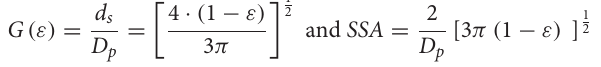
(arguing for a greater control over geometrical parameters).